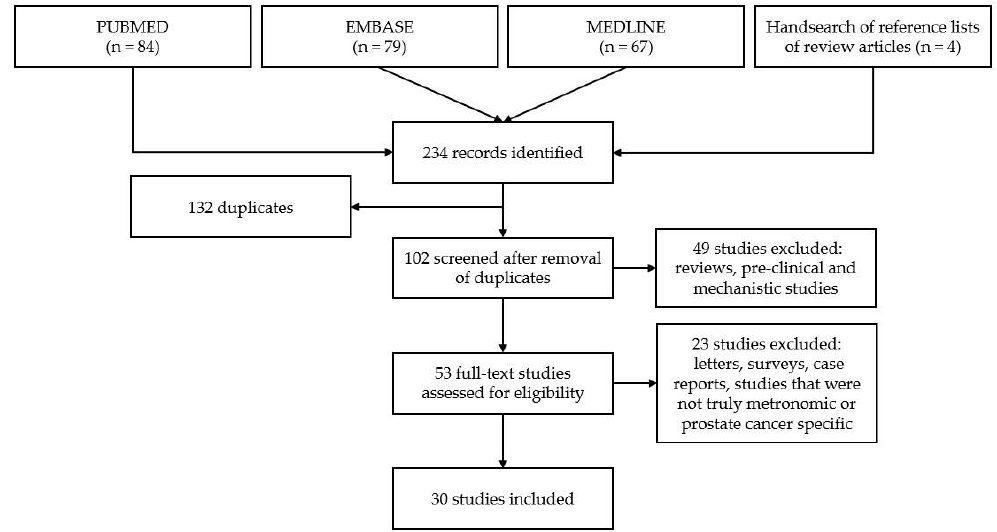
Figure 1. Flow diagram of search strategy.